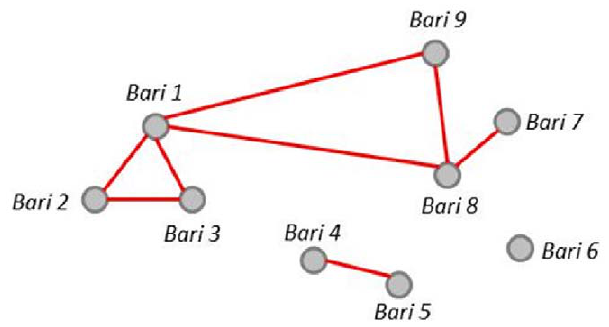
Figure 2. Graph network example of bari -level kinship social connections. A ‘‘0’’ indicates no social connection between two baris while a ‘‘1’’ indicates a kinship-based social connection exists.